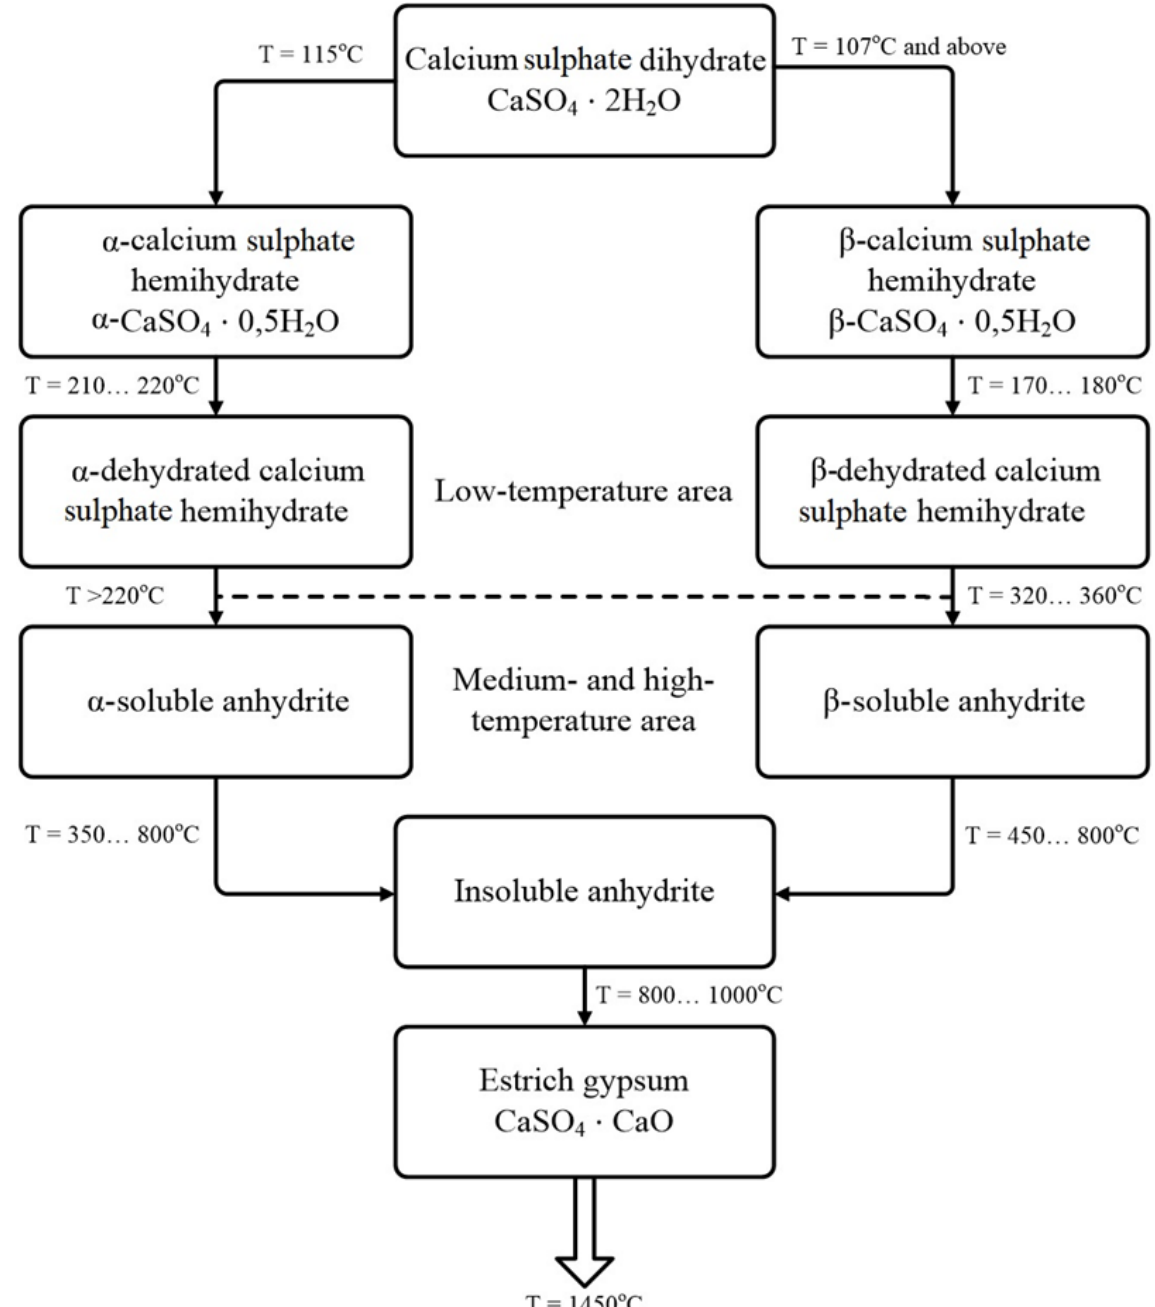
Figure 1. Scheme of formation conditions for the two modifications of calcium sulphate in their hydrated and anhydrous forms, according to Ferronskaya (2004). Low-temperature processes (up to ~220 °C) are described in the text. Upon further temperature increase (to 220 °C and above for α-dehydrated hemihydrate, to 320–360 °C for β-dehydrated hemihydrate) there are changes in the crystal lattices and the hemihydrates convert into α-soluble and β-soluble anhydrites. The main differences in properties between soluble anhydrites and the precursor hemihydrates are higher water demand, quick setting and reduced strength (Ferronskaya 2004). Further thermal treatment in the range 360–800 °C results in complete rearrangement of the crystal lattices, converting the soluble anhydrites into insoluble anhydrite. The latter has very low solubility in water, and the solution hardly sets or hardens. In the next temperature range ( T = 800–1000 °C) the insoluble anhydrite decomposes into calcium oxide, oxygen and sulphur dioxide. The product (Estrich- gypsum) obtained under these conditions is insoluble anhydrite with small amounts (2–3 %) of calcium